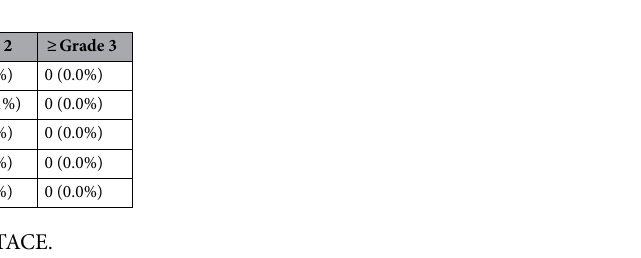
Figure 5. Follow up results. The median PFS was 21.4 months, and the 3-, 6- and 12 month PFS rates were 84.7%, 73.7% and 62.3%, respectively. The median OS was 24.6 months, and the 3-, 6 and 12 month OS rates were 93.9%, 87.6% and 65.2%, respectively.